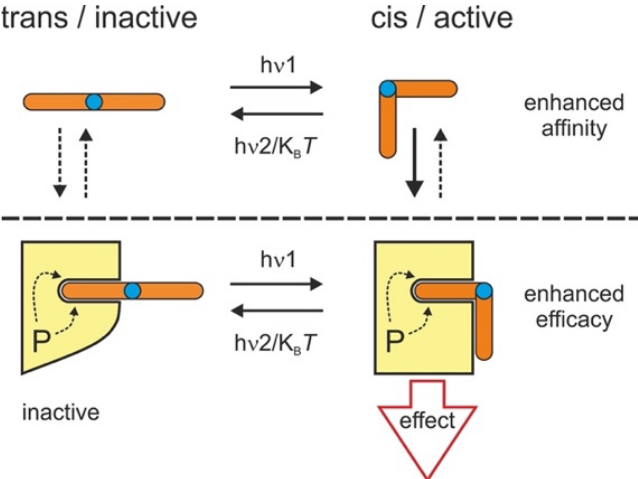
Figure 1. Hypothetical scheme of how azobenzene photolipids control their target proteins via a combined affinity and efficacy switch mechanism. Photoisomerization of photolipids between cis and trans potentially modifies both affinity and efficacy of photoligand action. As found for photochromic DAGs [2,3], the scheme depicts a scenario in which a light-induced (h√1) cis isoform exerts higher affinity as well as higher efficacy on its target, thereby initiating a productive change in this molecule (effect). That is why the “off-kinetics” in terms of returning the target to its inactive state may involve either dissociation of the cis isoform via its removal from the target´s surroundings as a result of cis–trans isomerization, either light-induced (h√2) or by thermal relaxation (K B T), or, alternatively, due to the relaxation of the cis isoform (h√2/K B T) within its binding pocket.